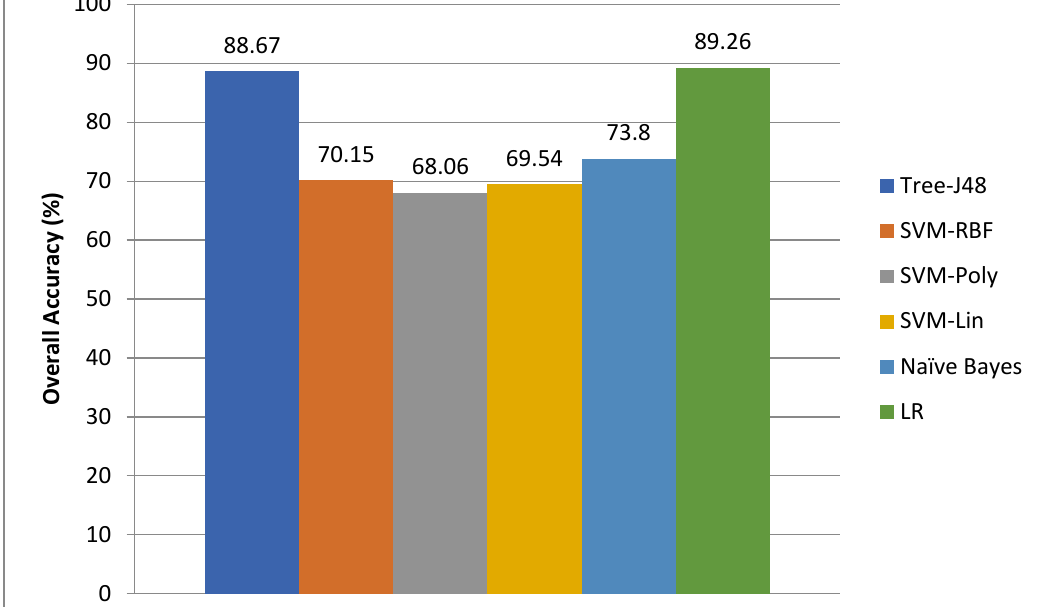
Figure 4. Overall Accurateness.